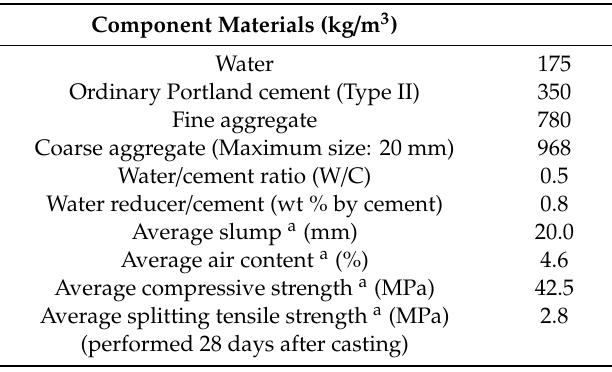
Table 1. Composition and characteristics of concrete.